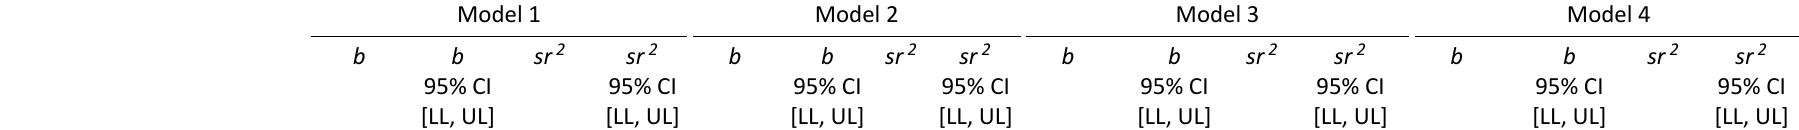
Table 1. (Cont.) Hierarchical regression predicting recommendation